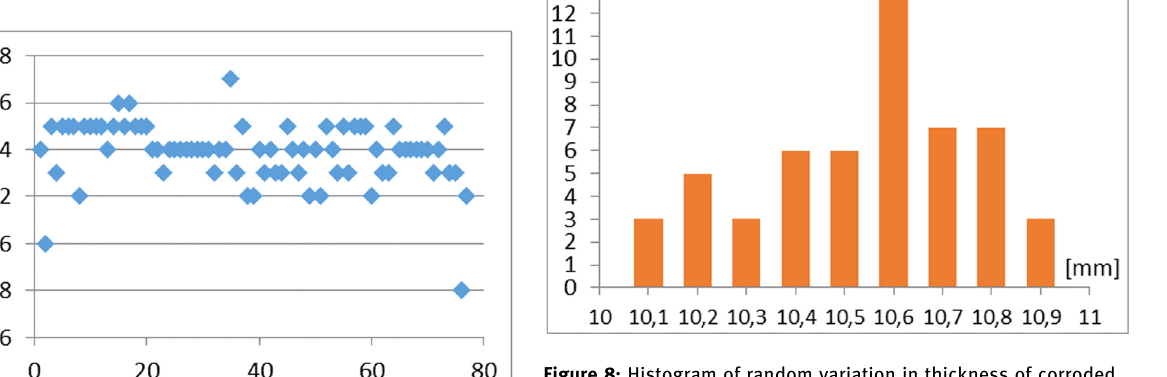
Figure 8: Histogram of random variation in thickness of corroded sheets obtained for the fi rst coating sheet of the tank number 1. The measurements were taken in 2006. Mean value ( estimated from the sample ) 10.54 mm, standard deviation 0.22 mm, coe ffi cient of var - iation